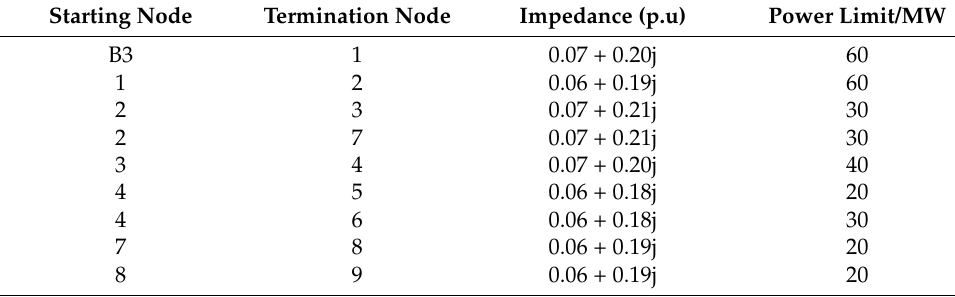
Table 5. Planning scheme for wind-PV-ESS of distribution network 1 in different periods.